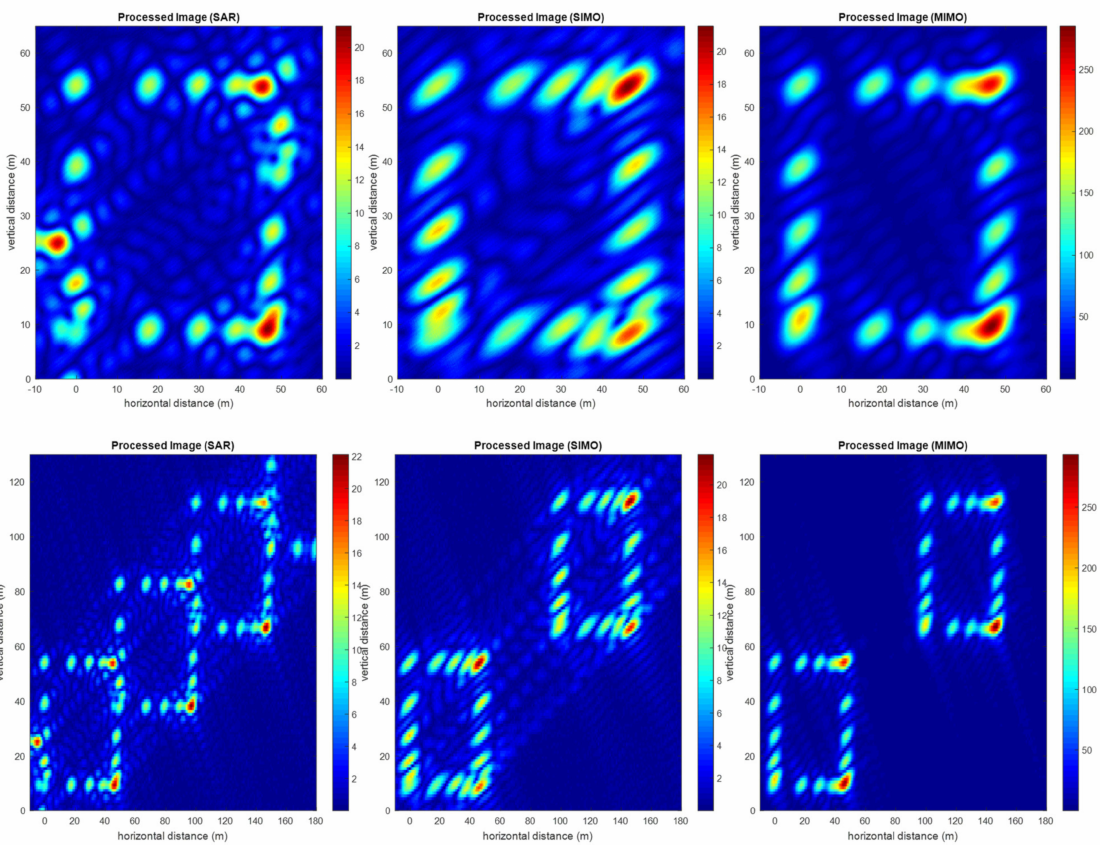
Figure 26. The simulated 2D images for Example 5 for SAR/SIMO/MIMO modes. Upper row: fine scene resolution (20 cm), small scene extent. Lower row: coarse scene resolution (1 m), large scene extent.